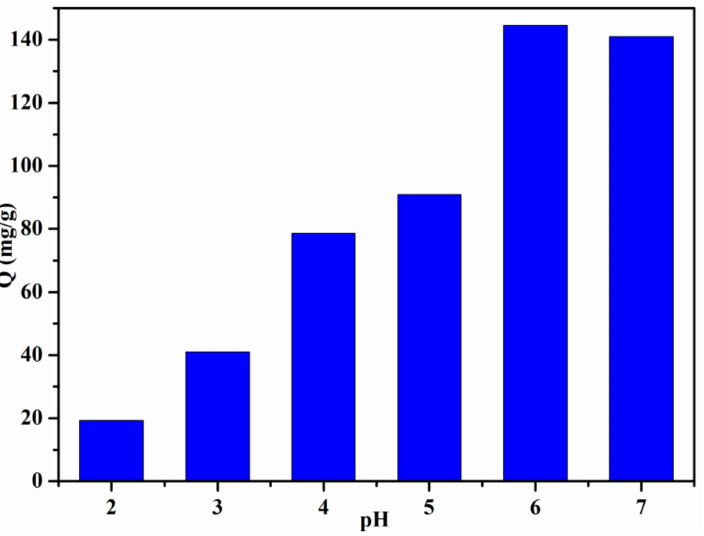
Figure 7. Effect of the pH values on the Ce(III) adsorption by magnetic PMMA-PGMA-PEI micro- spheres (Adsorbed dose = 80 kGy, dose rate = 20 kGy/pass, GMA concentration = 40 wt%, contact time = 24 h, C 0 = 200 mg/L, T = 298.15